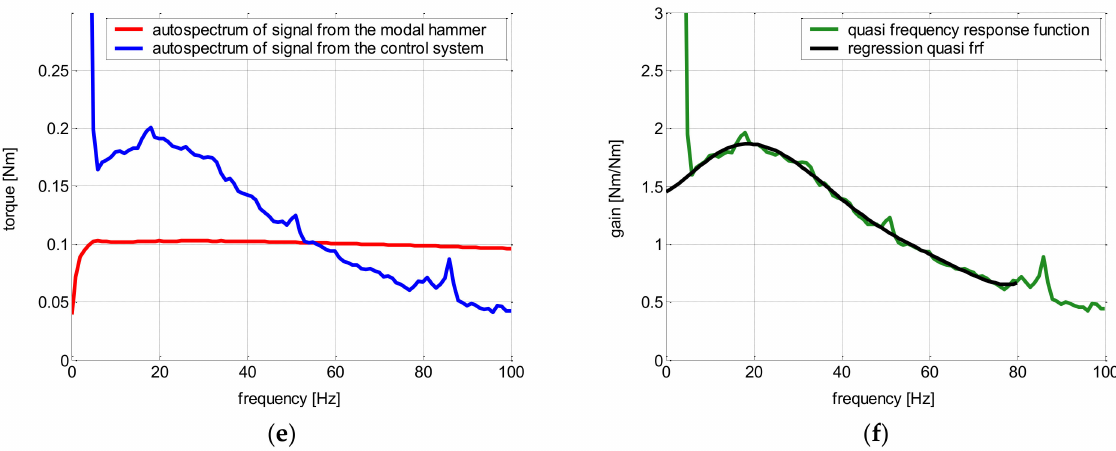
Figure 4. Data processing procedure: ( a ) force signal from modal hammer; ( b ) force signal converted to torque; ( c ) torque signal from spindle; ( d ) torque signal from spindle corrected by the mean value; ( e ) auto − spectra of both signals; and ( f ) quasi − frequency transfer